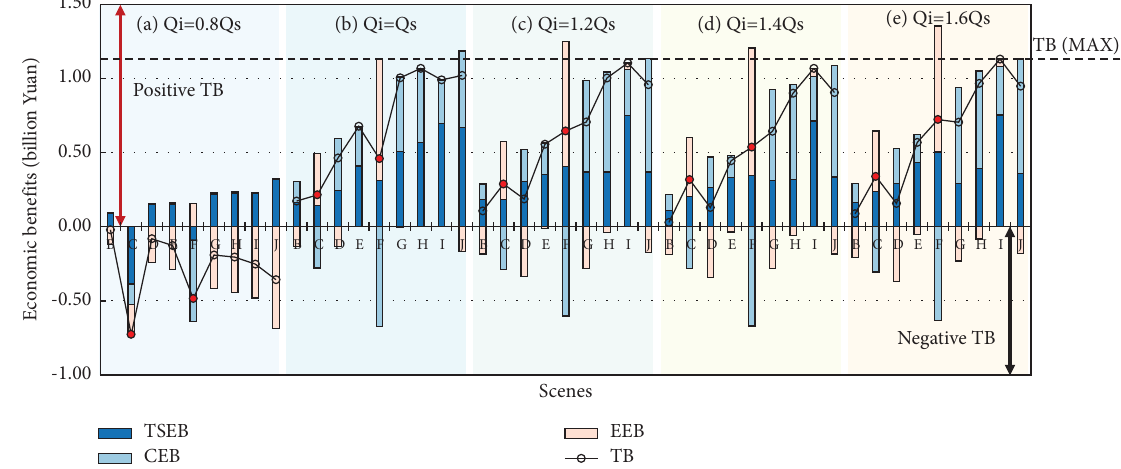
Figure 7: Te economic benefts in diferent scenes under diferent trafc conditions.